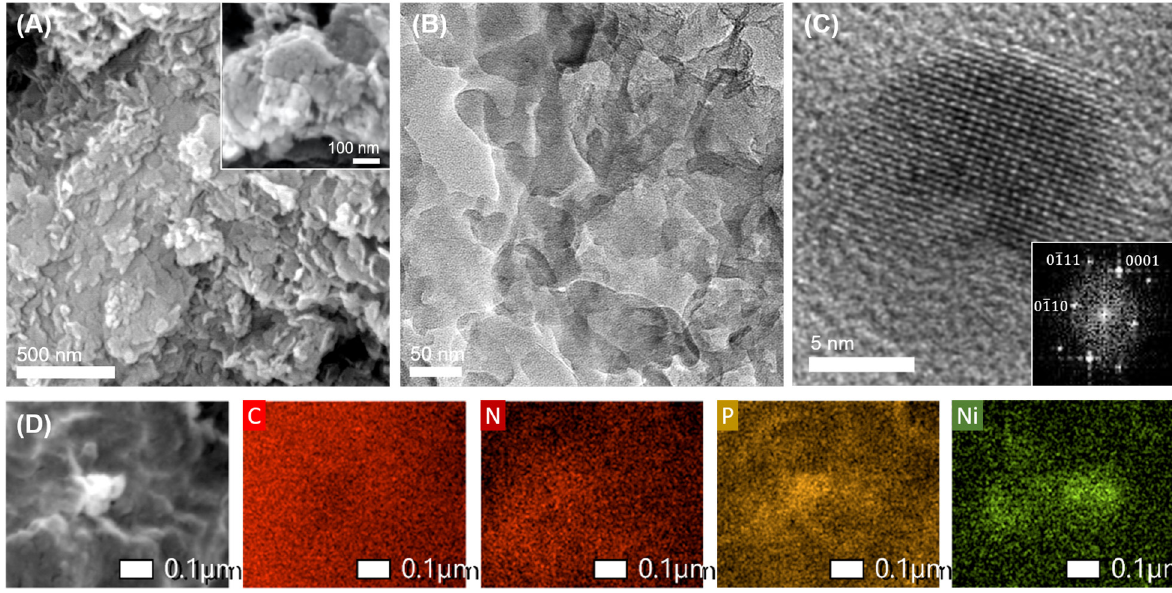
Figure 2. ( A ) FE-SEM images (Inset: high-magnification SEM image), ( B ) TEM image, ( C ) HRTEM (Inset: FFT pattern indexed to hexagonal P-62m Ni 2 P along the [100] zone axis) and ( D ) EDS elemental mapping images for 15-Ni 2 P/P-GCN catalyst.